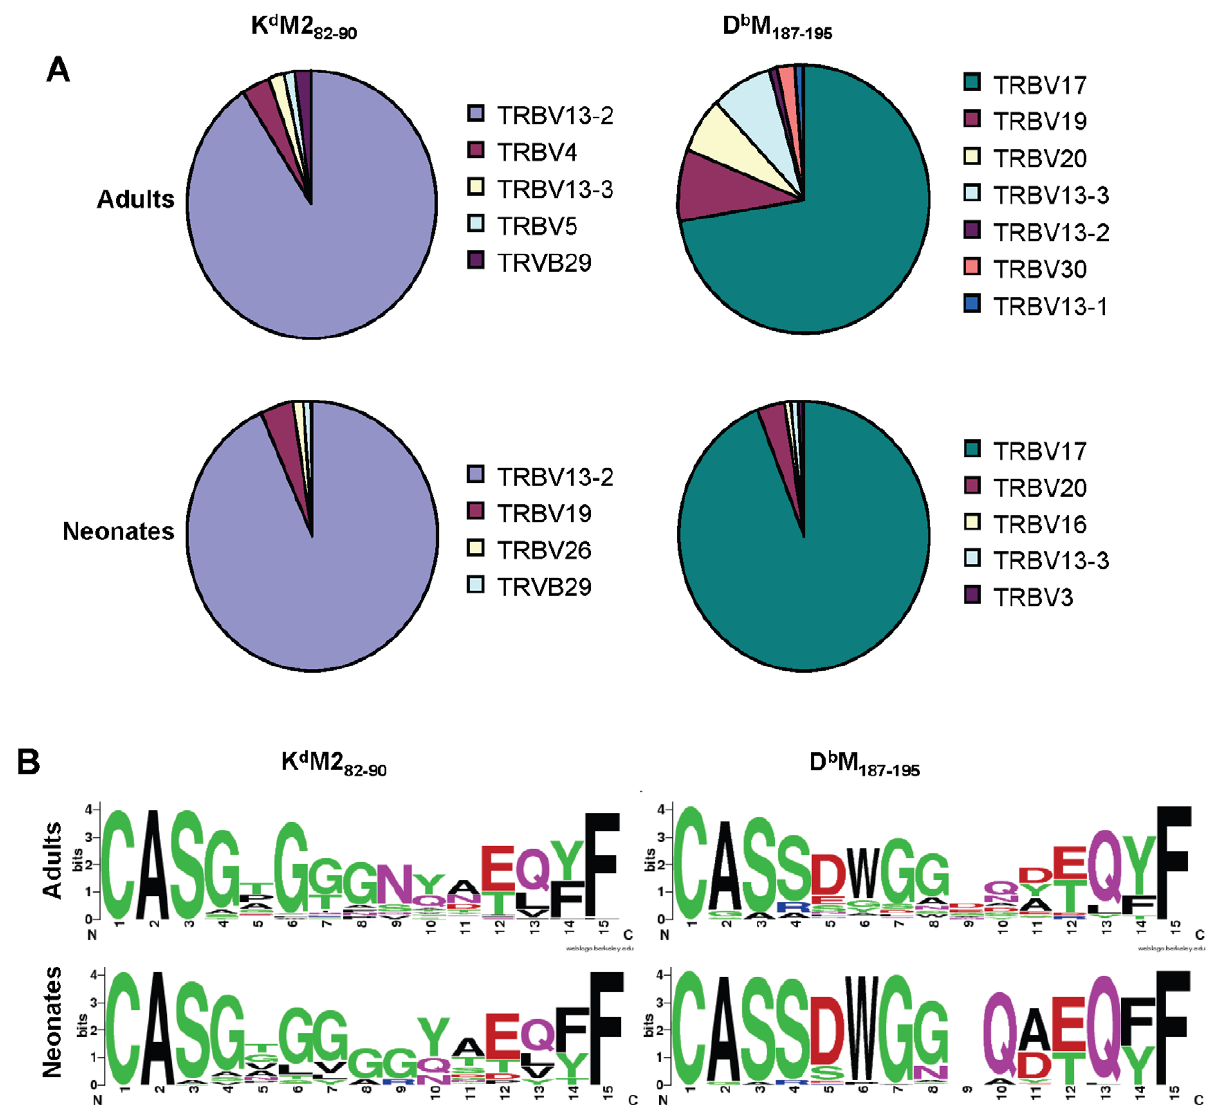
Figure 6. Single cell TCR b sequences from RSV-specific CD8 + T cell populations. (A) TCR V b usage in single CD8 + T cells sorted with K d M2 82-90 (left panels) or D b M 187-195 (right panels) tetramers from RSV-infected adult (upper panels) and neonatal (lower panels) CB6F1 mice (IMGT nomenclature). (B) CDR3 b consensus sequences generated on http://weblogo.berkeley.edu/for single CD8 + T cells sorted with K d M2 82-90 (left panels) or D b M 187-195 (right panels) tetramers from RSV-infected adult (upper panels) and neonatal (lower panels) CB6F1 mice. Single tetramer-positive cells were sorted and sequenced from two